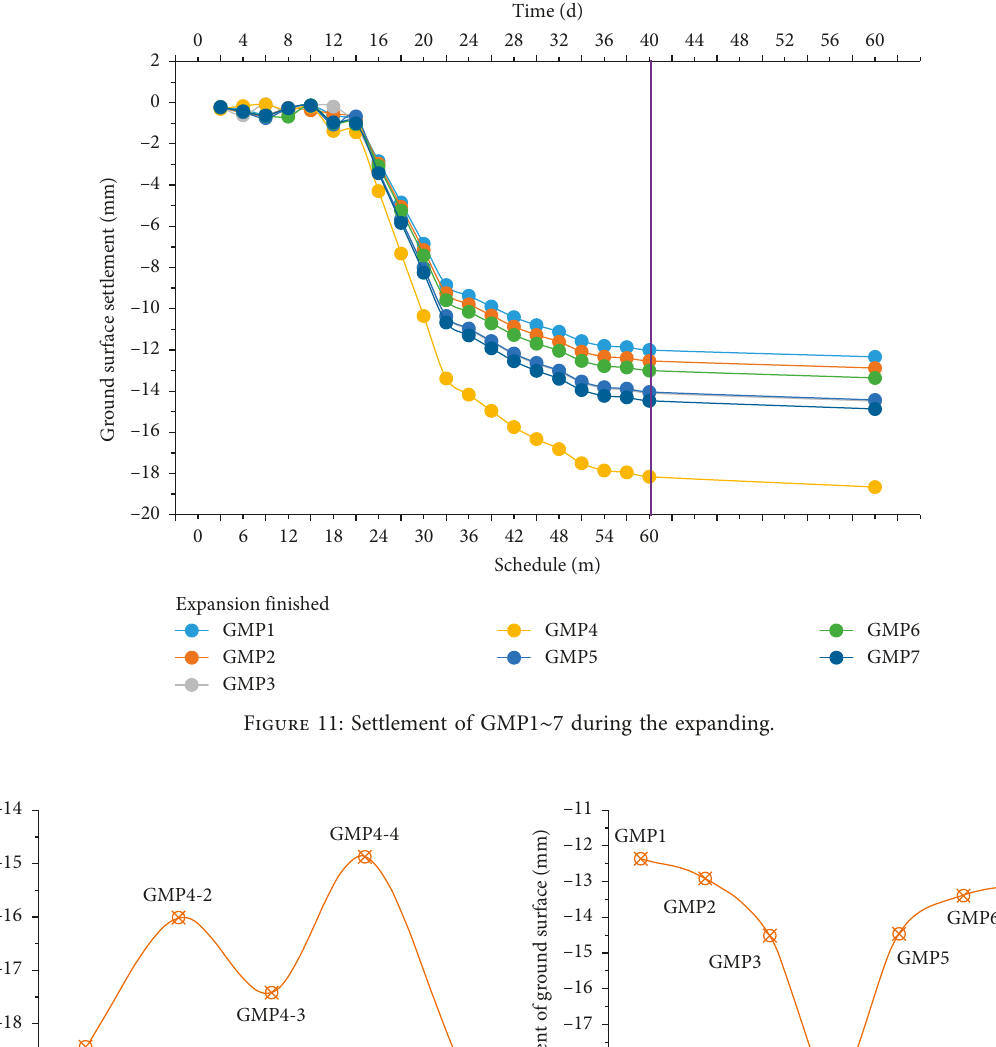
Figure 12: Settlement of the ground surface: (a) settlement of GMP4; (b) settlement of